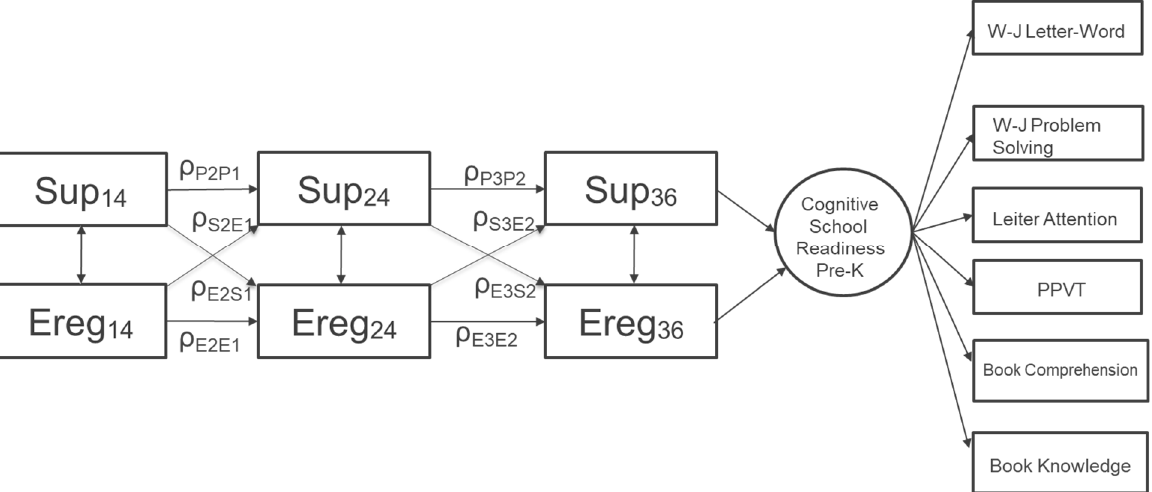
Figure 1. A hypothesized generalized autoregressive model for two series of repeated measures, including cross-lagged effects between predictors and a distal outcome.